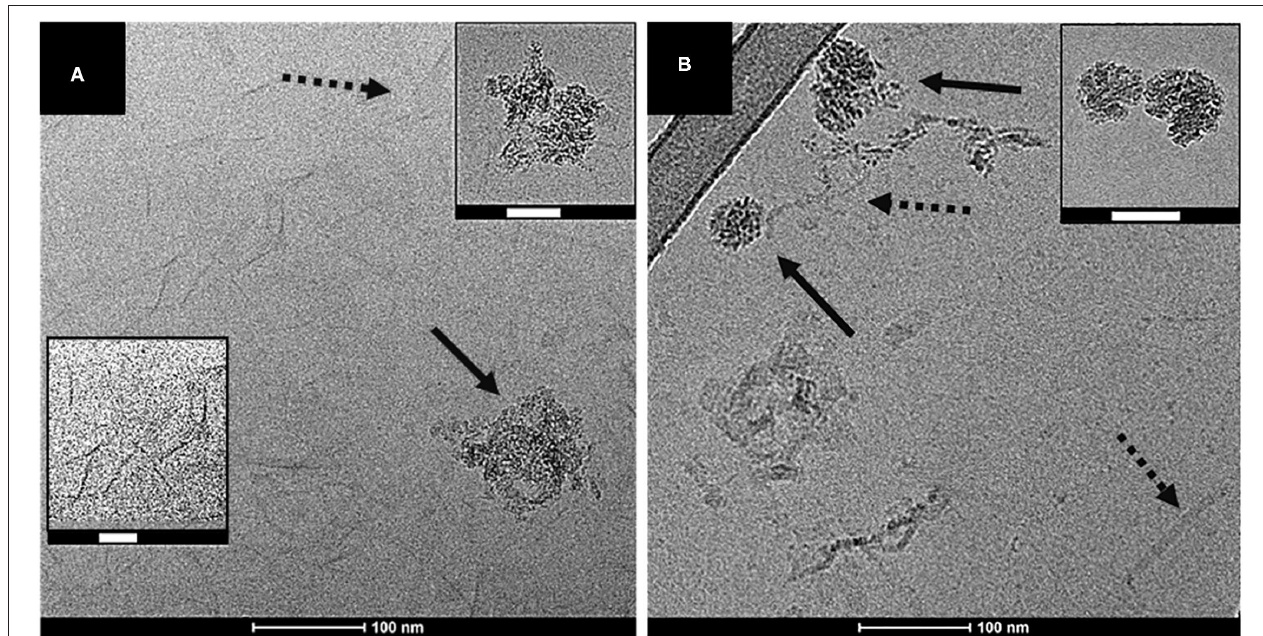
FIGURE 6 | Cryo-TEM images of (A) hot-water and (B) cold-water extracted DOM samples. Solid arrows highlight high electron density structures while dashed arrows highlight low electron density structures. Scale bars (100nm) are shown below the images. The insets in panel (A) show close ups of high and low electron density structures, while panel (B) displays high electron density structures only. The white scale bar in the insets represents 50nm.